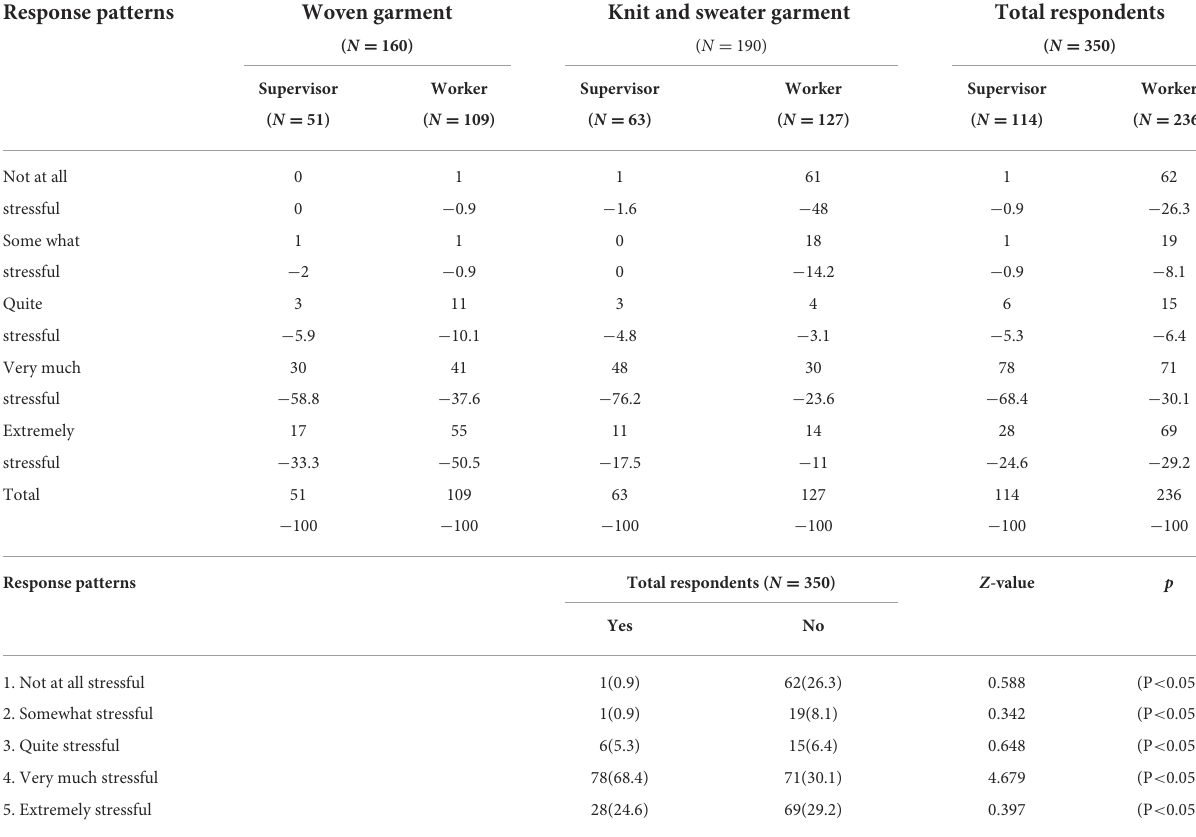
TABLE 7 Response patterns of the employees on the Occupational Stress based on Scale for measuring occupational stress (SMOS); ( N = 350). Response patterns